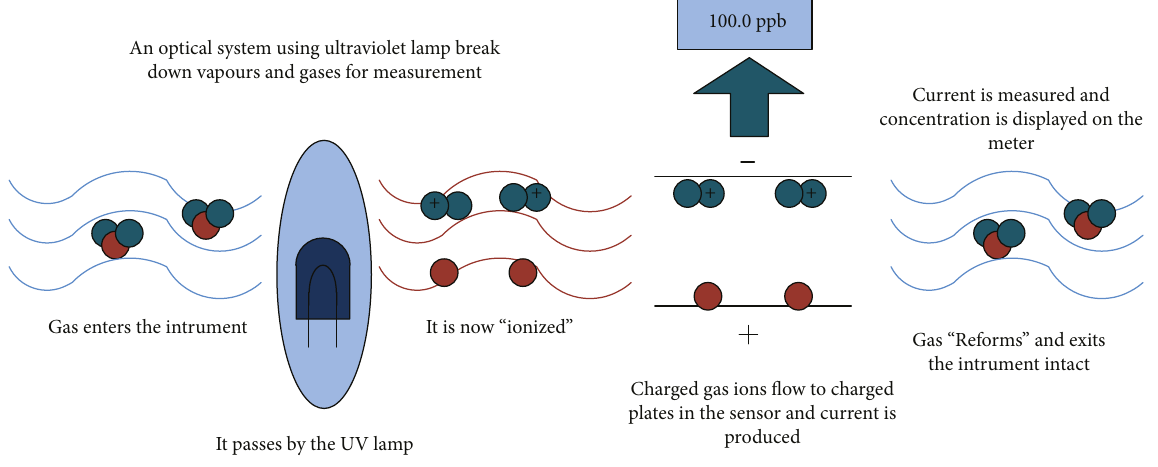
Figure 1: The working principle of